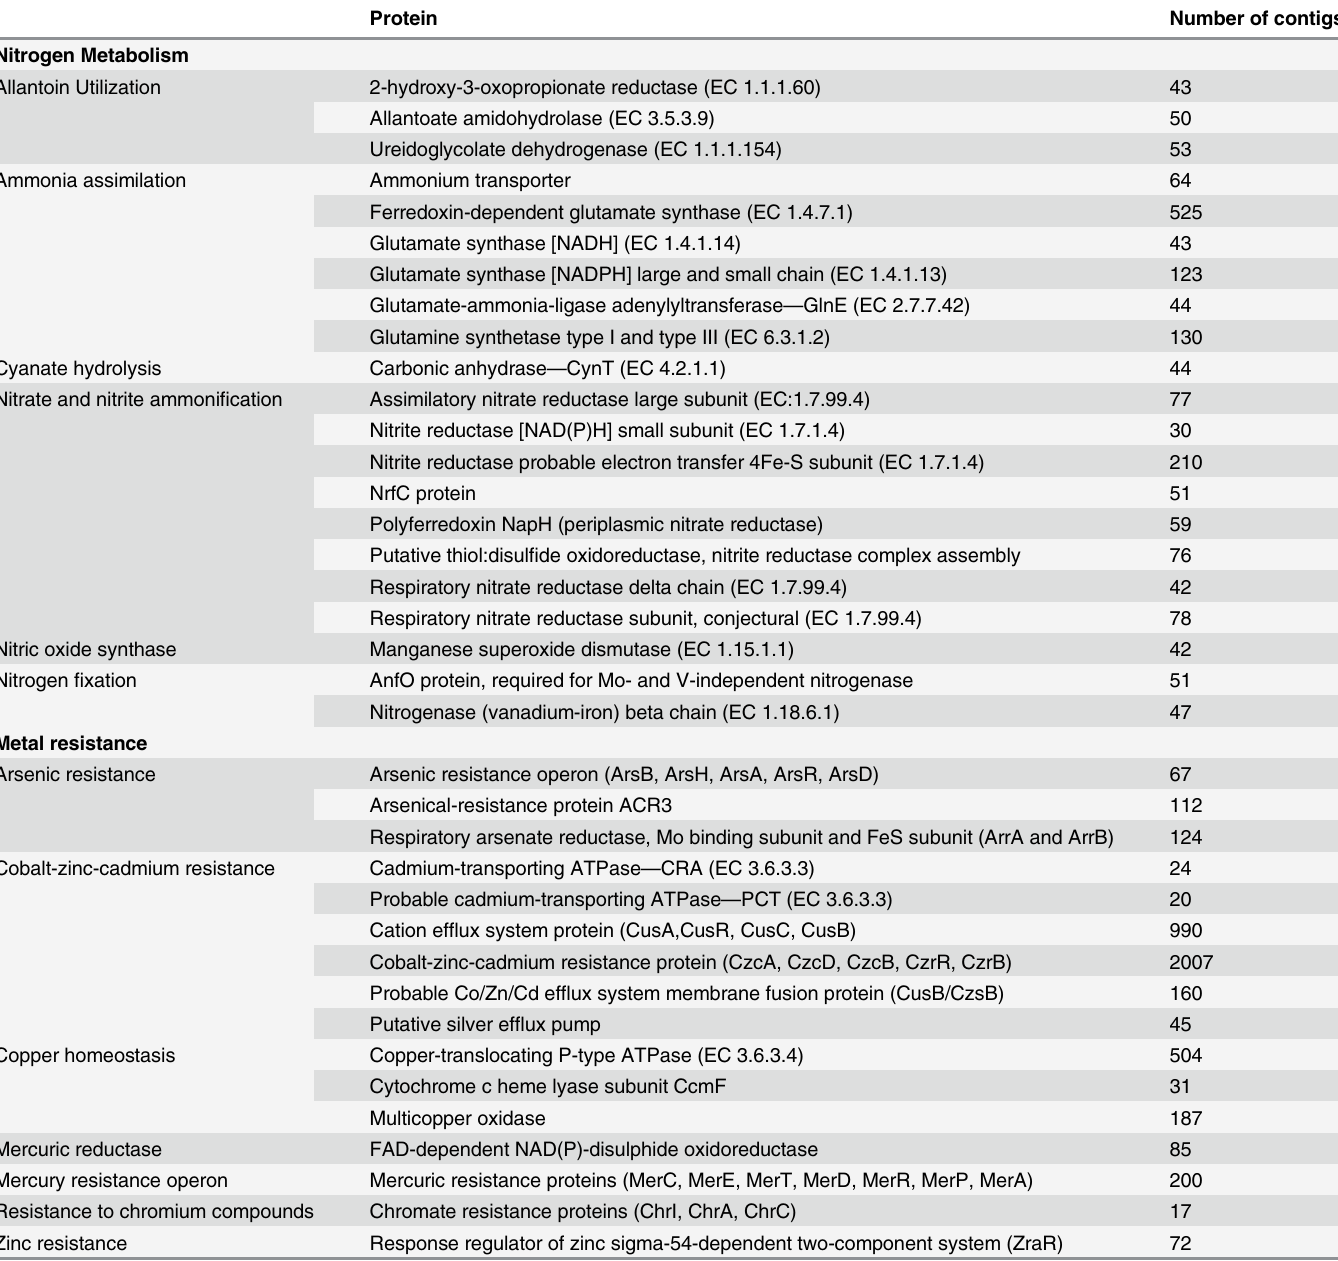
Table 1. The most frequent nitrogen metabolism and metal resistance proteins in the MSS metagenome obtained using the MG-RAST web server based on SEED database. Protein Nitrogen Metabolism Allantoin